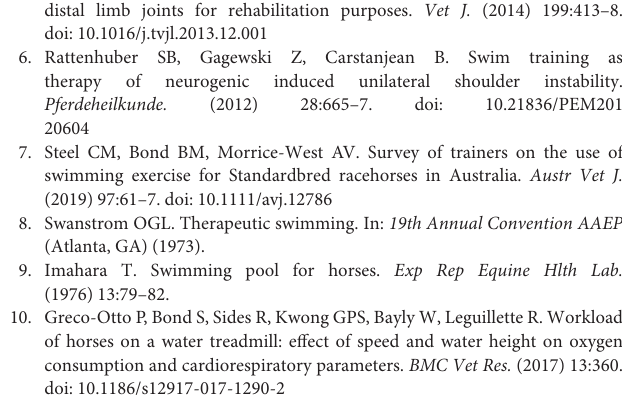
Supplementary Figure 1 | (A) Atypical swimming style - This horse relied solely on its hind quarters to swim and kept both front limbs in a semi-flexed position most of the time with only a forelimb swimming movement every 15–20 hind limbs cycles. This horse was excluded from the analysis for obvious reasons. (B) Atypical swimming style - This horse kept its forelimb fully extended during part of the protraction phase. This was similarly observed for both the left and right forelimbs. This horse was included in the